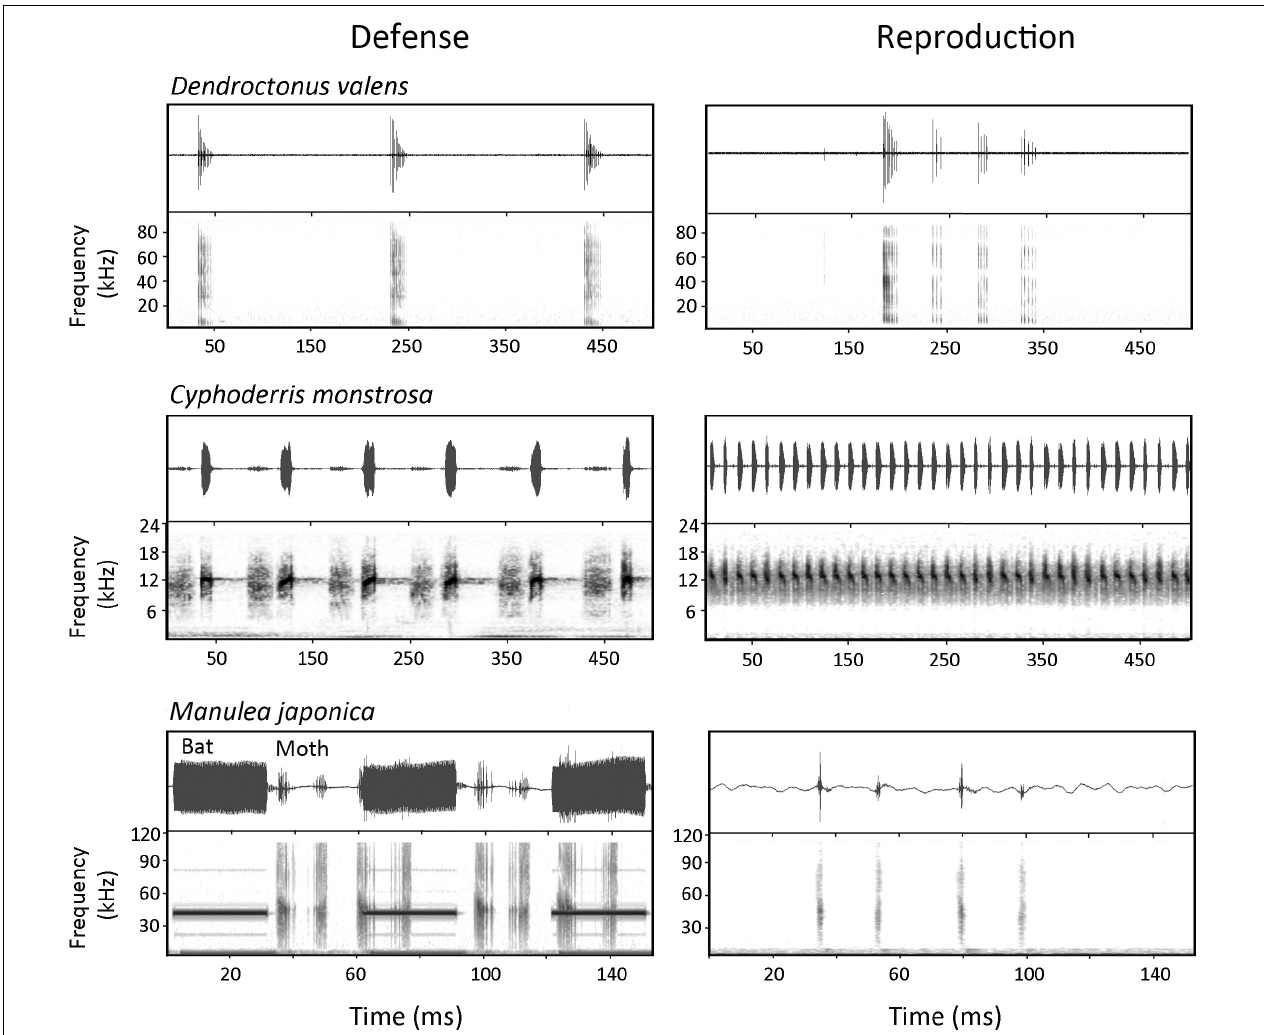
FIGURE 4 | Sounds produced by insects in both defense and reproduction to illustrate contextual differences in signal characteristics. In a defensive context, the male bark beetle Dendroctonus valens produces ‘simple’ chirps that are temporally simple compared to the more complex ‘interrupted’ chirps that are predominant during courtship displays. The male orthopteran Cyphoderris monstrosa produces a series of disyllabic chirps as defense sounds while the calling song is a continuous series of rapid trills. The male Manulea japonica tiger moth produces a burst of tymbal clicks in response to simulated bat calls (simulated bat calls in the spectrogram are shown as longer duration calls at ∼ 40 kHz that precede the moth clicks), while the courtship tymbal clicks are simpler in structure. Sound files were contributed by the Yack Lab ( D. valens ), A. Mason ( C. monstrosa ), and R. Nakano ( M. japonica ). See text and Table 1 for further details on these